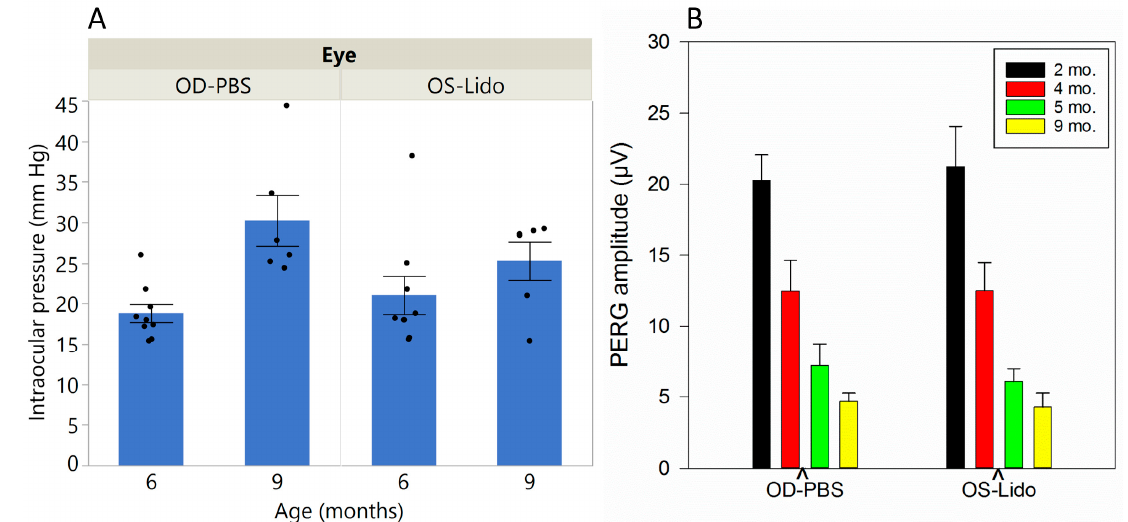
Figure 3. Intraocular pressure (IOP) and PERG amplitude as function of age in Lidocaine-treated and PBS-treated D2 mice. ( A ) IOP increases with age with no apparent differences between Lidocaine-treated and PBS-treated D2 mice. Bars represent the mean ± SEM (6 mo., N = 9; 9 mo., N = 6); black dots represent measurements in individual mice; ( B ) PERG amplitude declines with increasing age, with no apparent differences between Lidocaine-treated and PBS-treated D2 mice. Bars represent the mean ± SEM (2 mo., N = 7; 4 mo., N = 20; 5 mo., N = 9; 9 mo., N = 17).